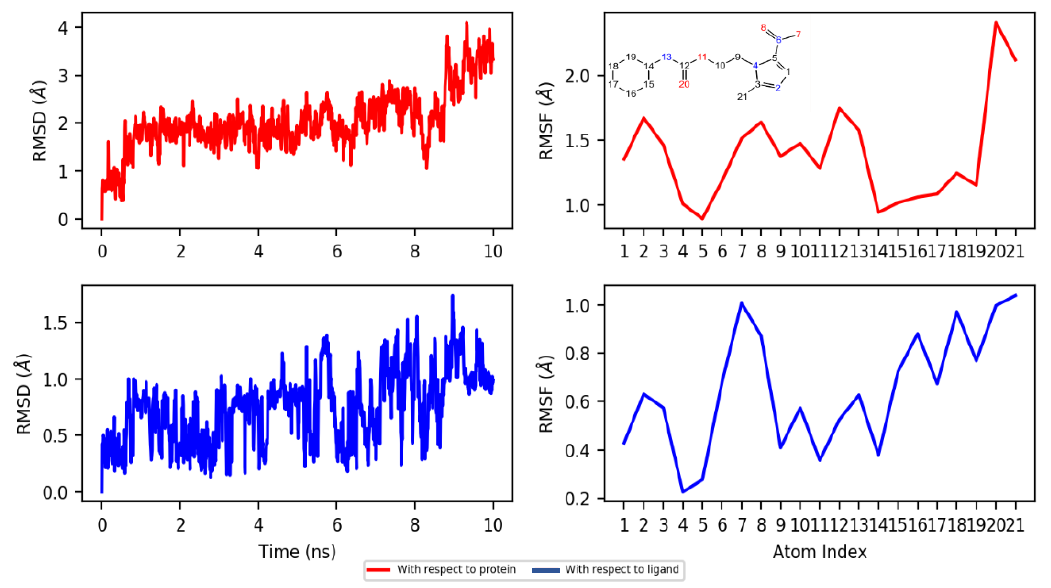
Figure 9. Dynamics of the top pose of compound 1 in the ligand recognition site of PFOR. RMSD (left) and RMSF (right) are shown with respect to protein fit (red) and the initial pose (blue).